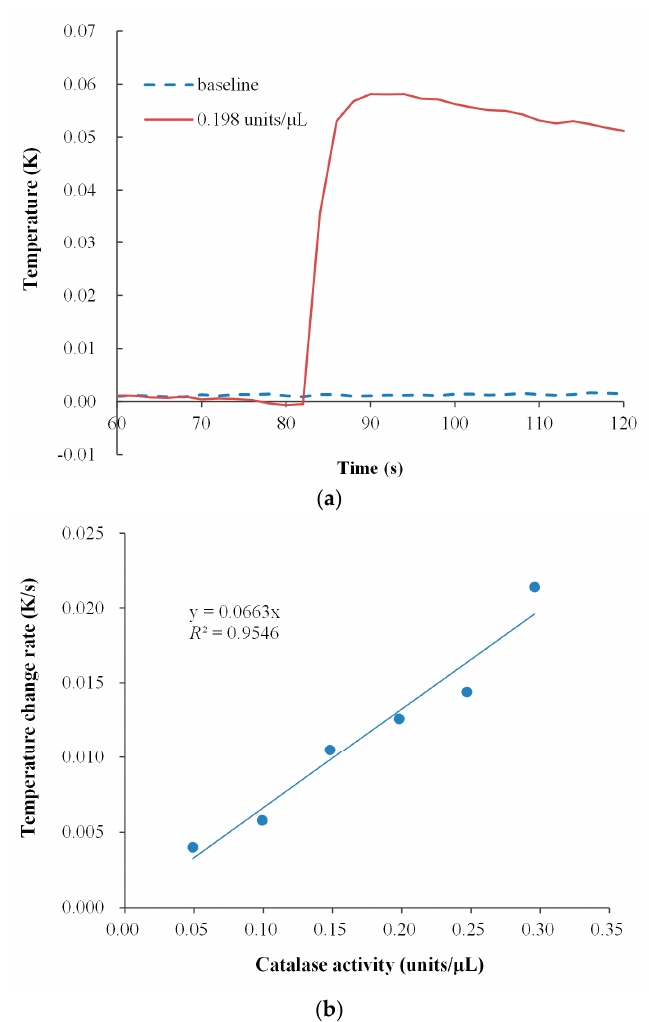
Figure 8. Detection of purified catalase, from bovine liver (C3155). ( a ) Thermogram example of catalase activity 0.198 units/µL; ( b ) Temperature change rates between different enzyme activities.